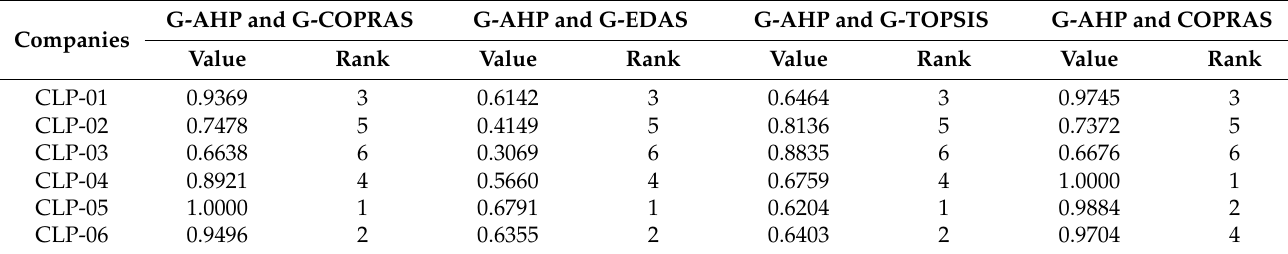
Table 15. Ranking of compared